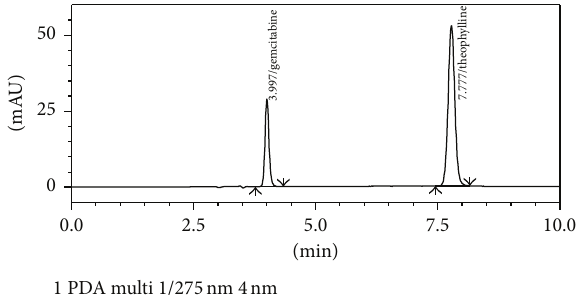
Figure 3: Representative chromatogram showing signals of gemc- itabine and theophylline in the selected mobile